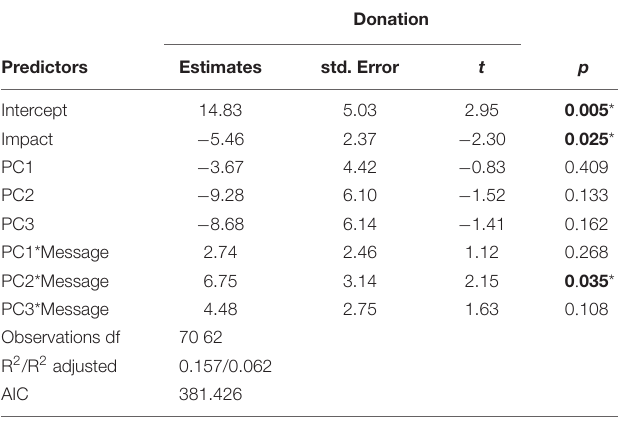
TABLE 2 | Linear regression model for the effects of message impact and personal characteristics on money